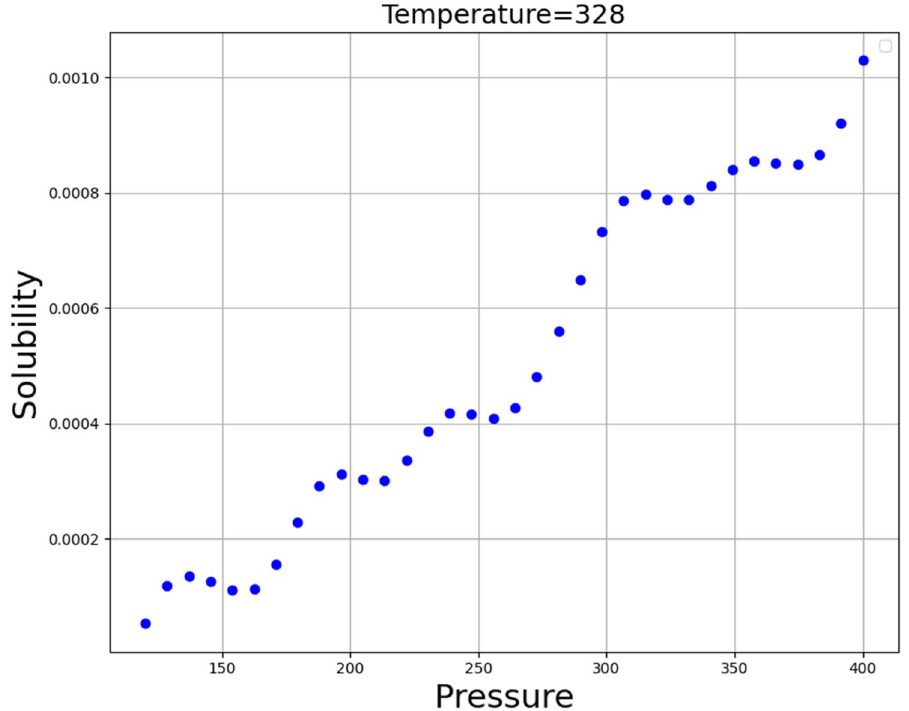
Figure 7. Solubility (mole fraction) based on pressure (bar), temperature (°K).